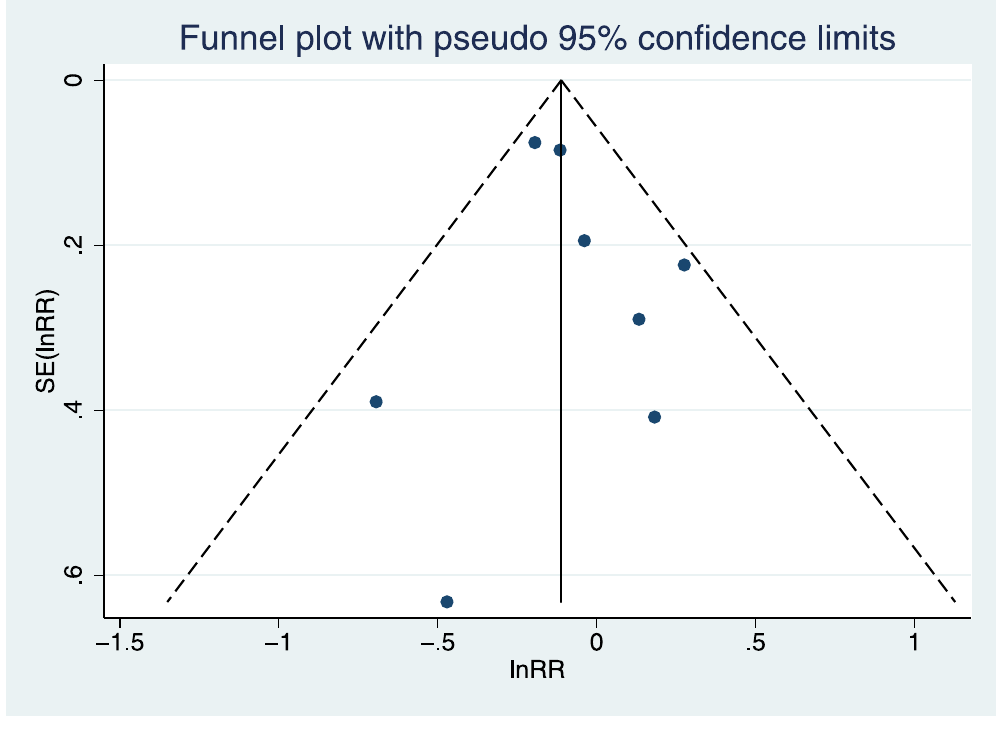
Fig 5. Funnel plot of standard error (in (relative risk)) against in(relative